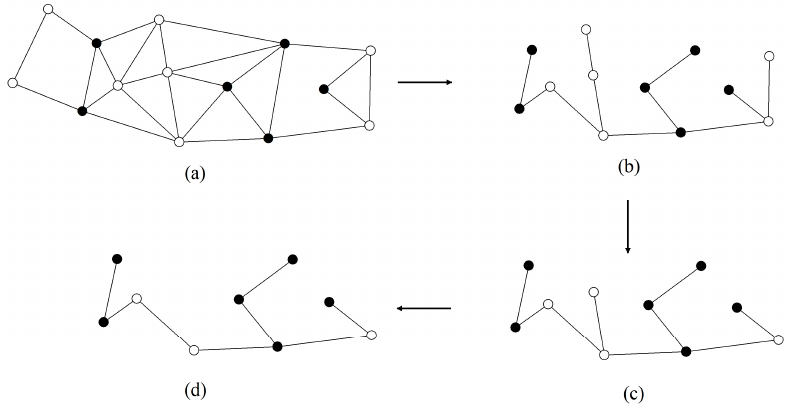
Figure 6. Connectivity maintenance of the selected strokes.